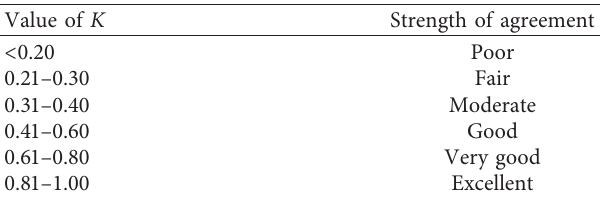
Table 1: Interpretation of the strength of agreement according to K